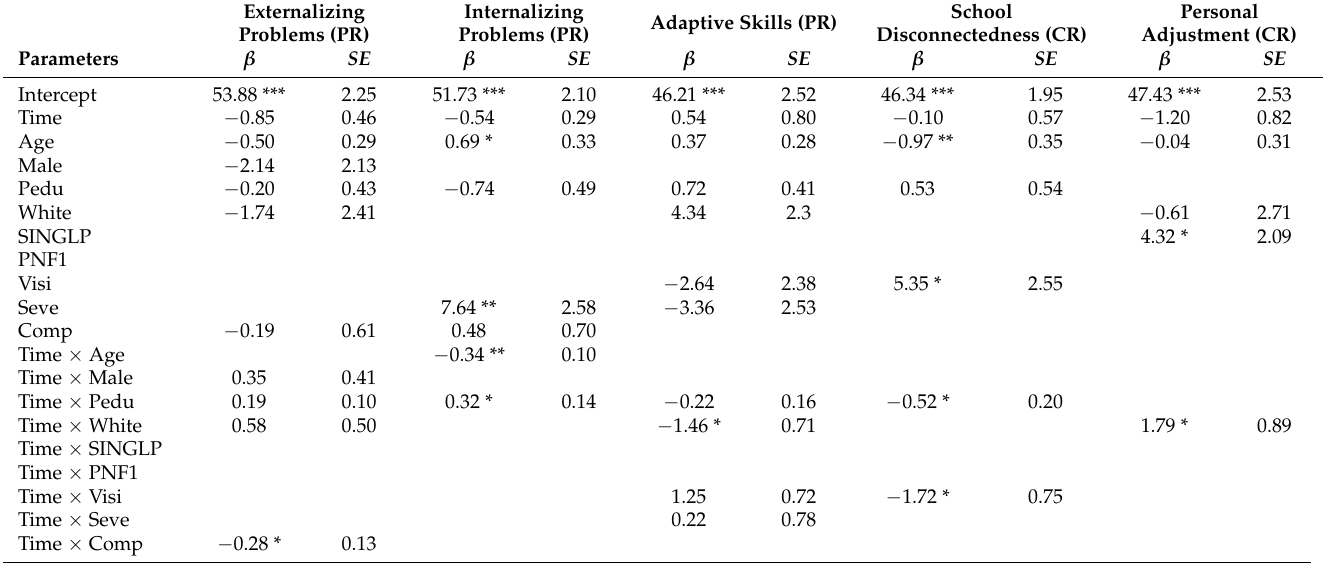
Table 2. Multilevel Modeling Coefficients of Predictors of Socioemotional Outcomes in the Combined